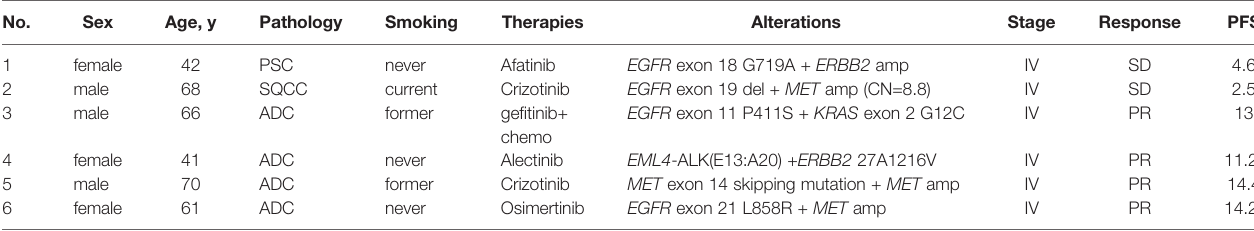
TABLE 4 | Characteristics of patients harboring other co-occurring actionable drivers receiving targeted